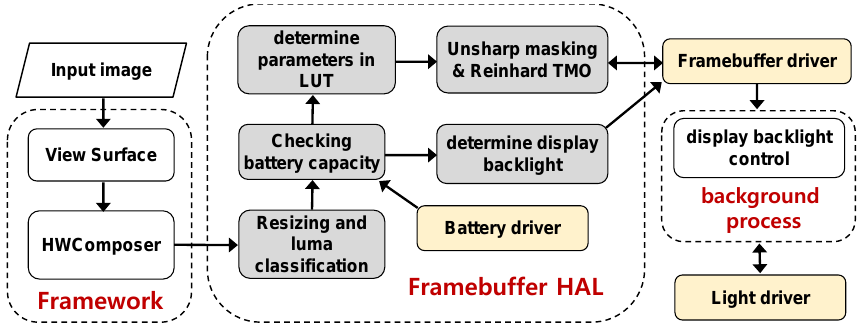
Figure 3. Overall flow of the tone-mapping-aware DVS scheme. Display backlight scaling uses the background process of the Android operating system using a native app. The variable brightness value in the HAL is passed to the framebuffer driver and the background process reads the information of the framebuffer driver to recognize the variable brightness value to synchronize the brightness values. Then, backlight scaling is performed by controlling the supply voltage of the AMOLED display by transmitting variable brightness information to the light